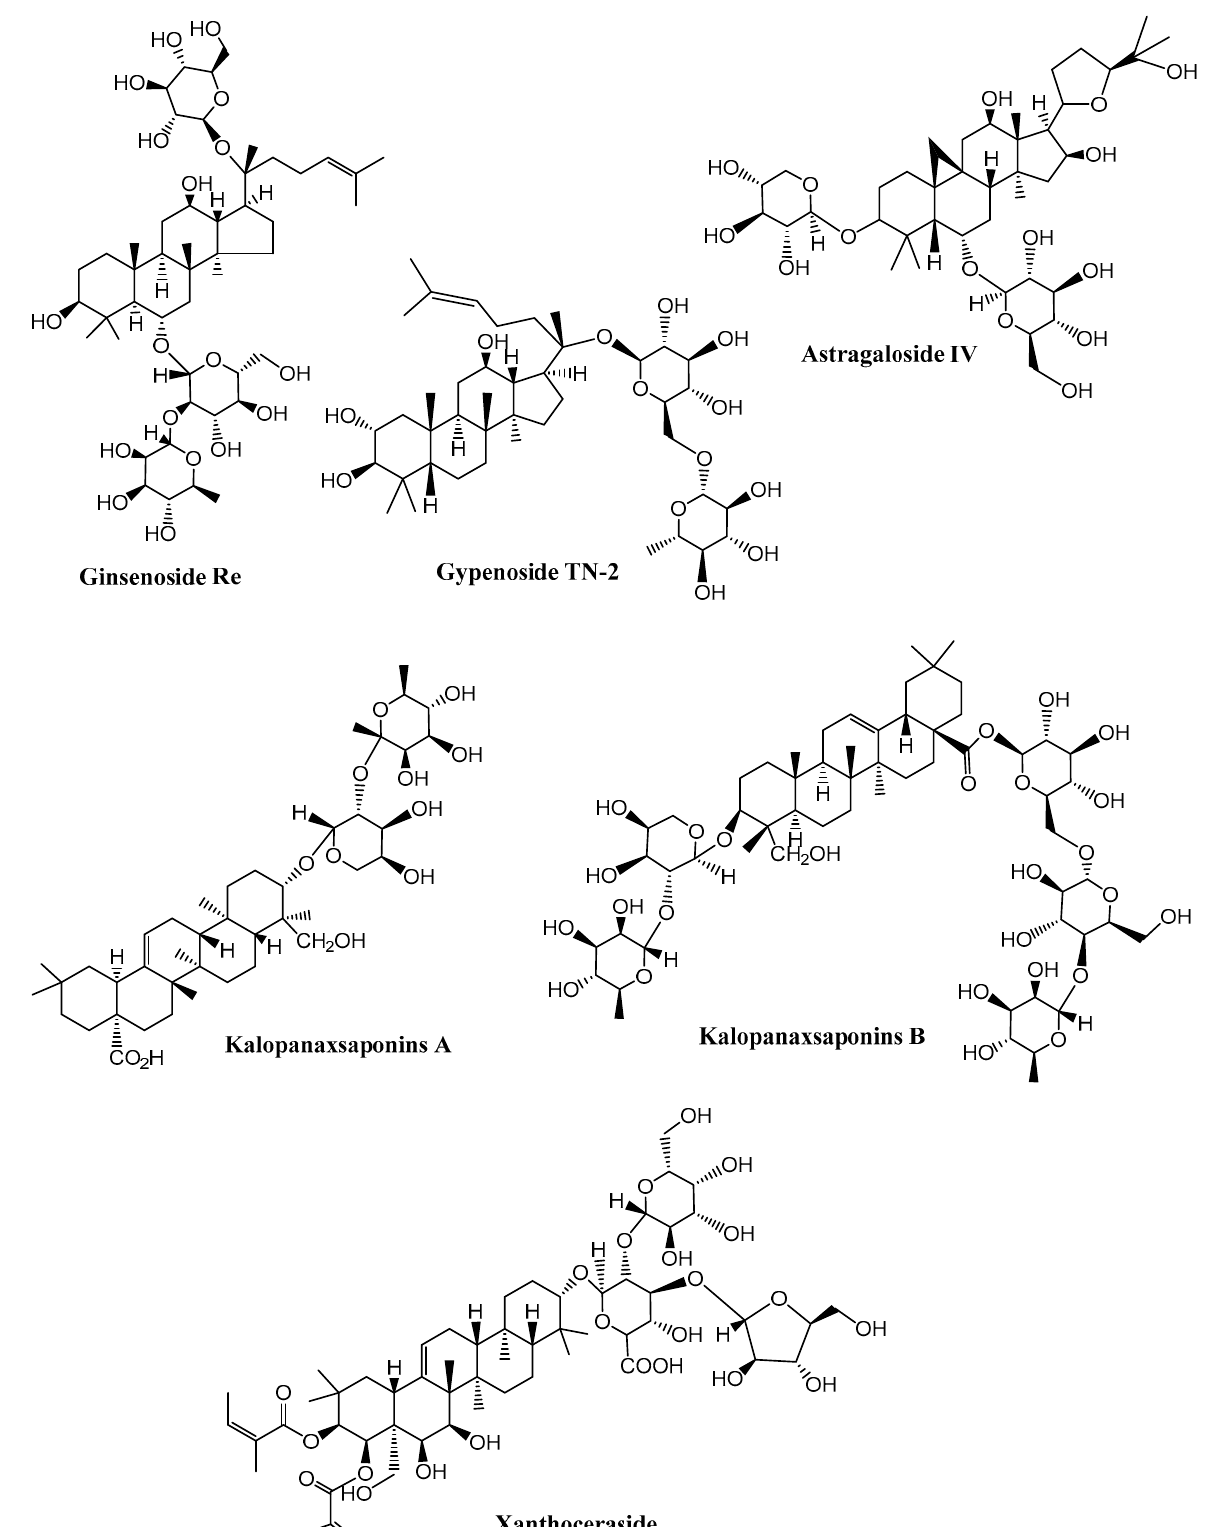
Figure 5. Neuroprotective saponins from plants. (Chemical structures were generated using ChemBioDraw ultra version 14).